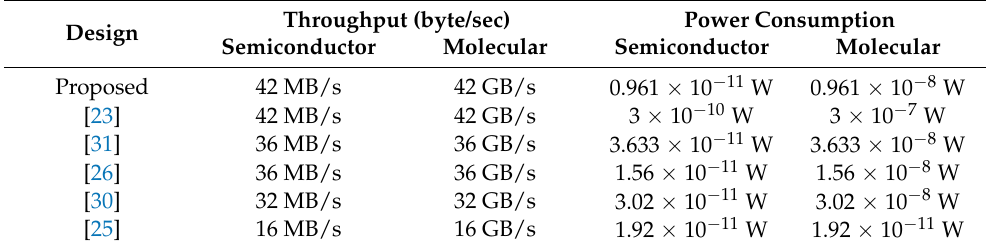
Table 4. Performance Comparison of Throughput and Power